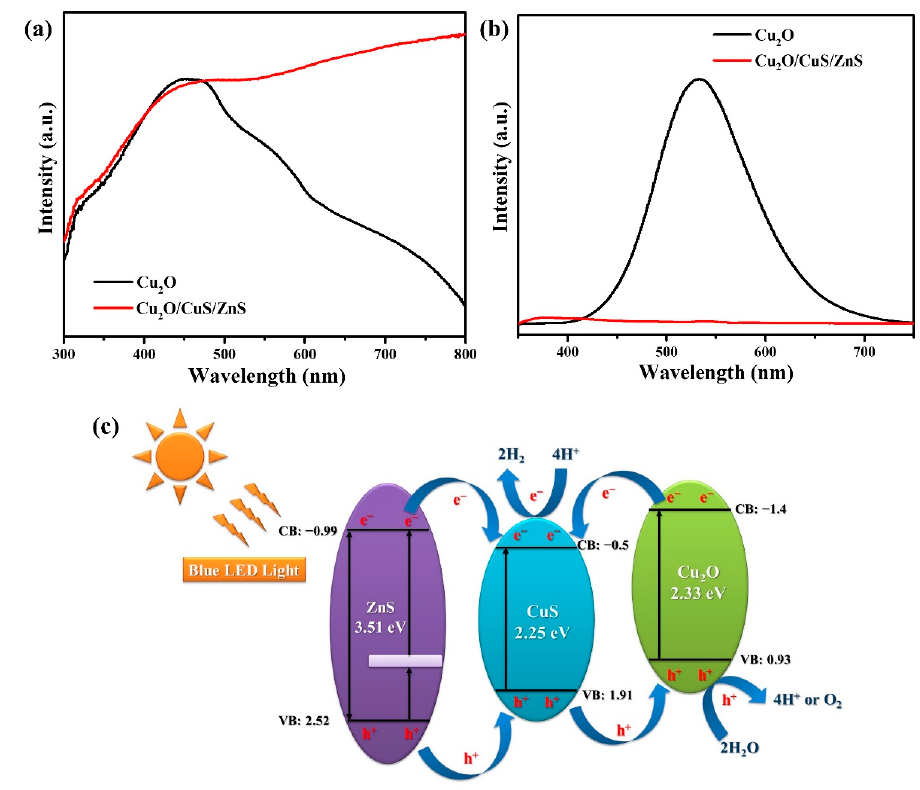
Figure 6. The ( a ) UV–Vis absorption and ( b ) PL spectra of Cu 2 O nanostructures and the Cu 2 O/CuS/ZnS nanocomposite. ( c ) Schematic diagram of the electron transfer mechanism of the Cu 2 O/CuS/ZnS nanocomposite under blue LED light